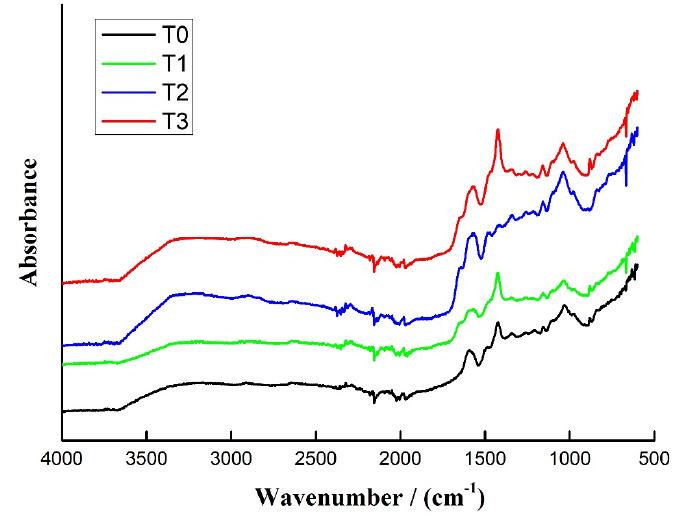
Figure 5. FTIR spectra of the highly branched polymer-modified tannin resins.